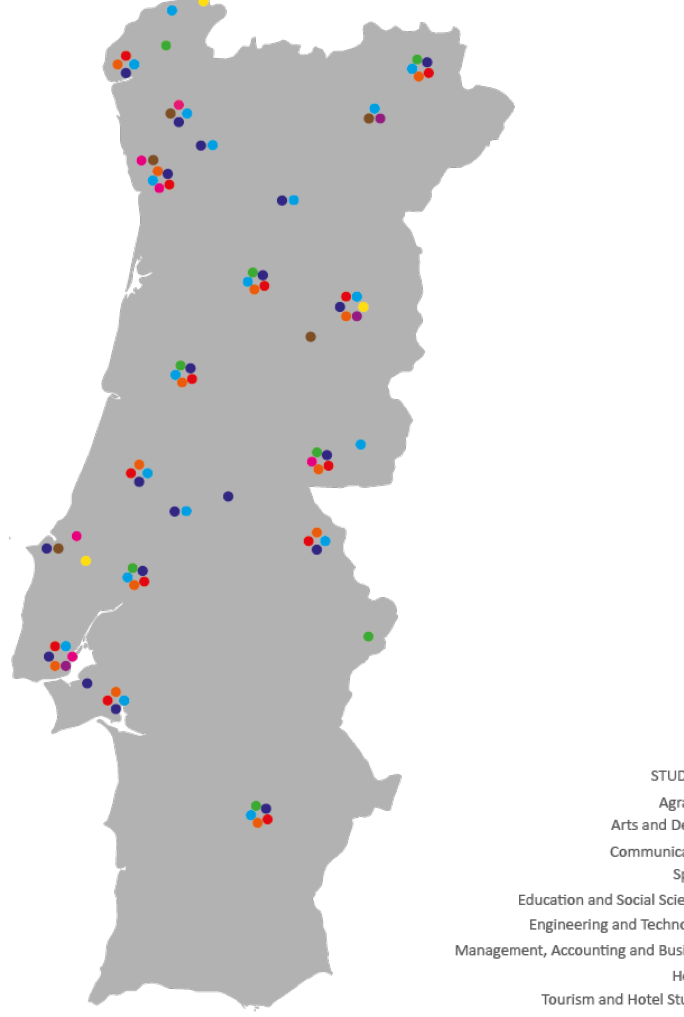
Figure 1. Polytechnic institutions geographic dispersion in mainland Portugal.